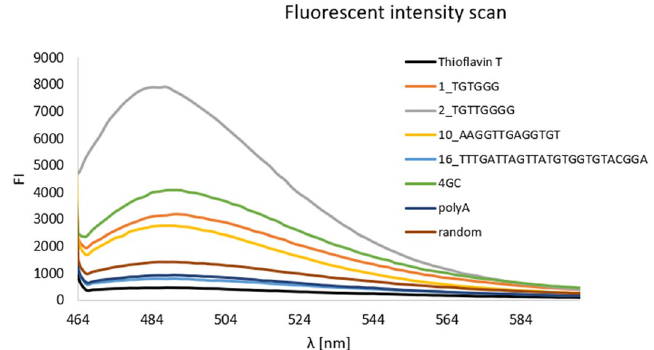
Figure 4. Thioflavin T (ThT) fluorescence assay. We tested four oligonucleotides representing selected telomere sequences from Sachcaromyces sp., Zygosaccharomyces sp., Lachancea sp., Torulaspora sp., and Kluyveromyces marxianus ; three controls—one G4-forming sequence (called 4GC) and two negative controls (polyA and random). The G4 propensity was confirmed in vitro by both methods in three out of four telomere sequences tested as well as in positive control (in this figure, Supplementary table S4). The only sample sequence which did not form G4 in vitro was the one that was negative by prediction also. (Figure created using Adobe Photoshop